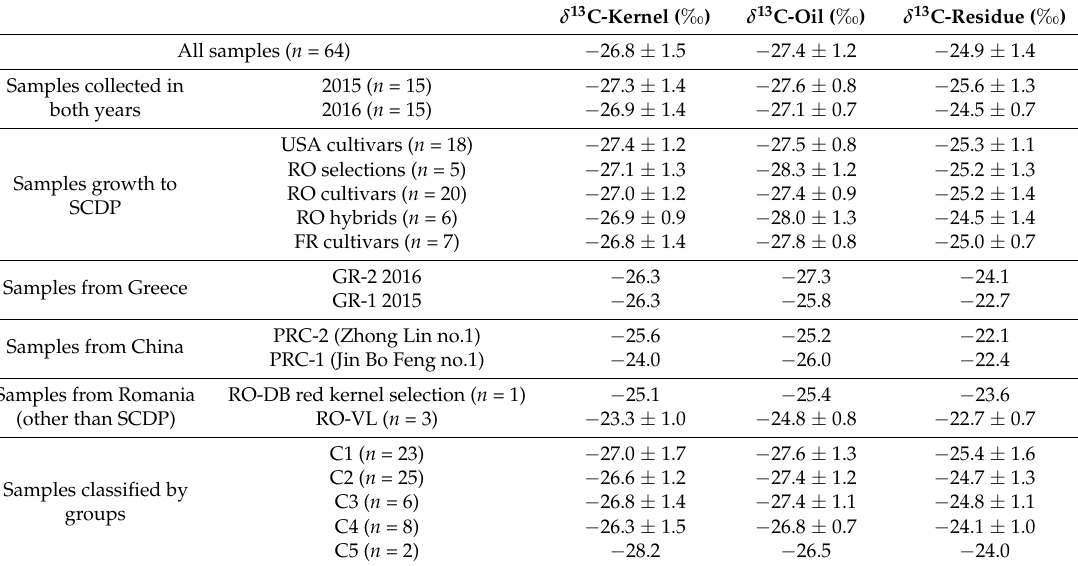
Table 2. Stable carbon composition (mean values) of the investigated walnut